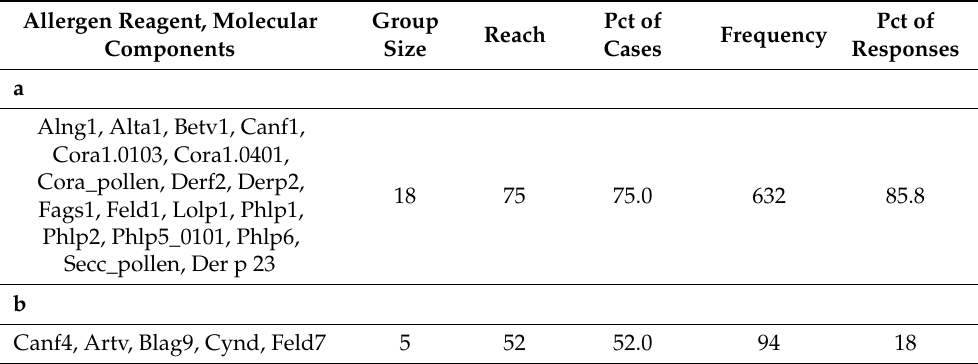
Table 6. Best reach and frequency by group size—18 molecular components with high (Class 3) molecular components reached 75 patients (75.0%), the frequency of positivity was at a rate of 632. b. The level of specific IgE in Classes 3 and 4 to these molecular components reached 52